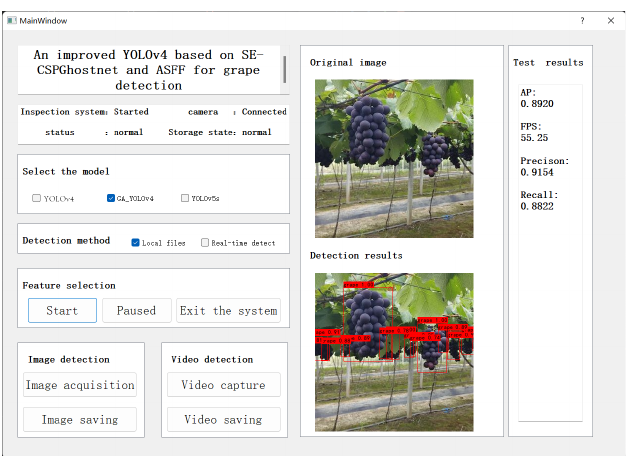
Figure 17. Human–machine interaction.